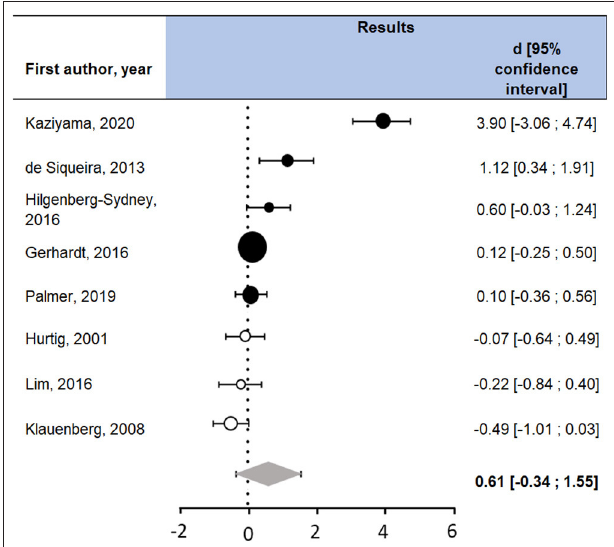
FIGURE 2 | Studies included in the meta-analysis with measures of TDT. FM, participants with fibromyalgia; HC, healthy controls; SD, standard deviation. Question marks indicate non-reported data. A positive d (in black) can be interpreted as a hypoalgesia in participants with fibromyalgia compared to healthy controls, whereas a negative d (in white) means there is a hyperalgesia in participants with fibromyalgia compared to healthy controls. The summarized Cohen’s d is represented by the gray diamond. Confidence intervals containing zero means the d is not statistically